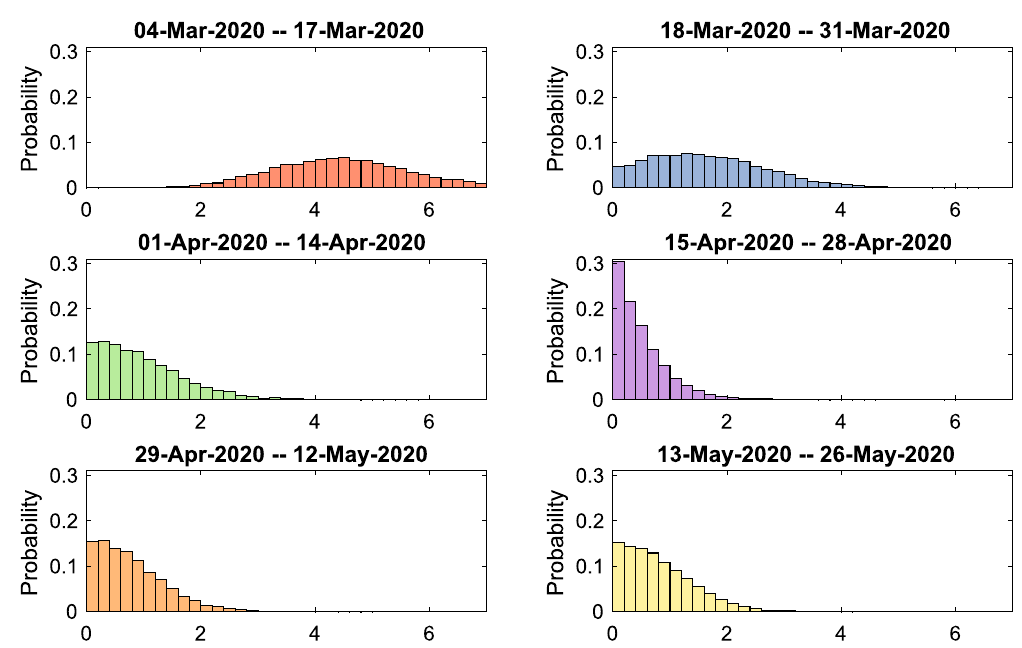
Figure 8. Posterior distributions of the effective reproductive number in Model 1, for the six fortnight periods starting from 04/03/2020 until 26/05/2020. Analysis using the full